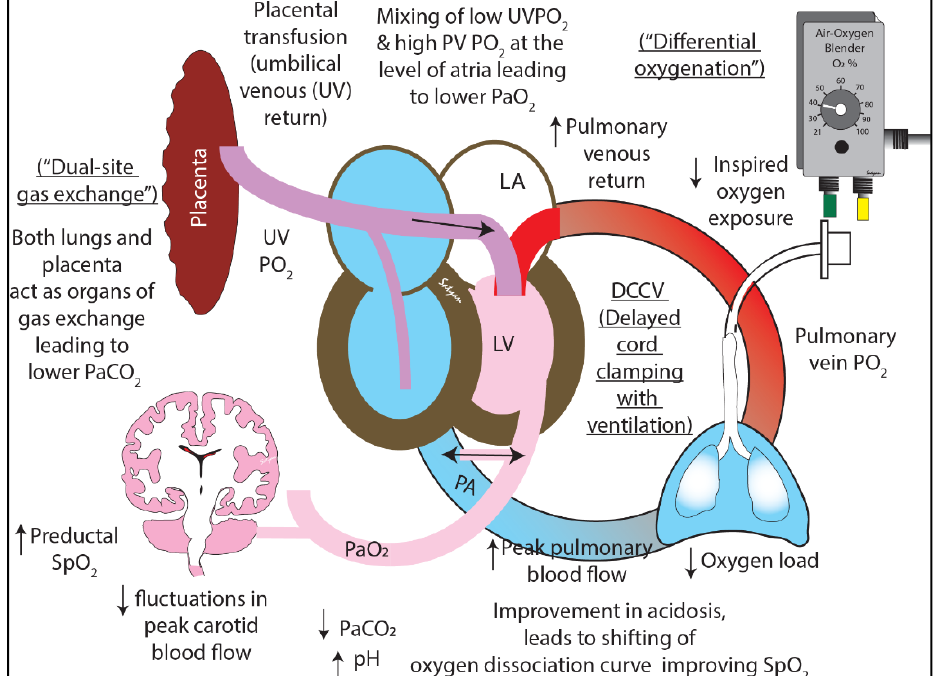
Figure 8. The benefits of delayed cord clamping and ventilation (DCCV) for 5 min in a lamb model of preterm asphyxia. With positive pressure ventilation and an intact cord, there was a mixing of lower umbilical vein oxygen tension (UVPO 2 ) with higher pulmonary venous oxygen tension (PVO 2 ) leading to overall systemic lower oxygen tension (PaO 2 )—“differential oxygenation” with alveolar hyperoxia but systemic normoxia. With the placenta and lungs simultaneously acting as organs of gas exchange, the arterial carbon dioxide (PaCO 2 ) was lower (“dual-site gas exchange”). Copyright Satyan